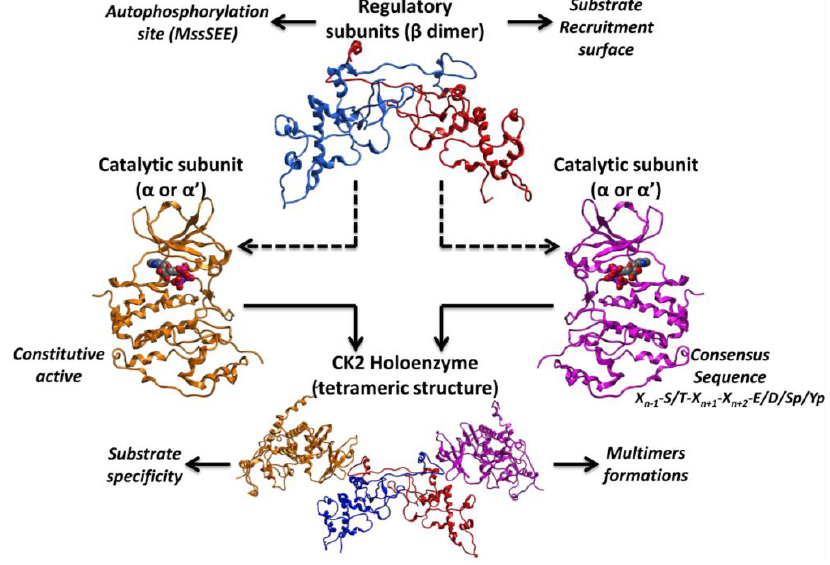
Figure 2. Representation of CK2 structure; catalytic subunits (α and α’), regulatory β dimer and the holoenzyme structure are highlighted.